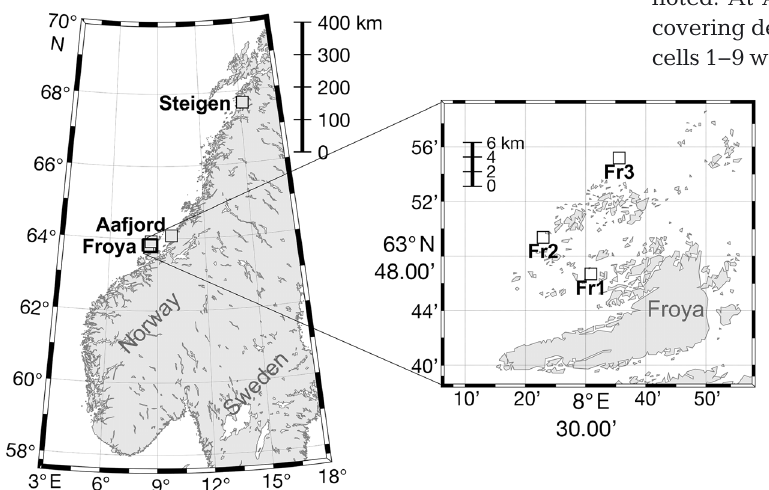
Fig. 1. Locations of the acoustic Doppler current profilers (ADCPs) at Åfjord (Aafj), Steigen (Ste), and the Frøya archipelago (Fr1, Fr2 and Fr3)